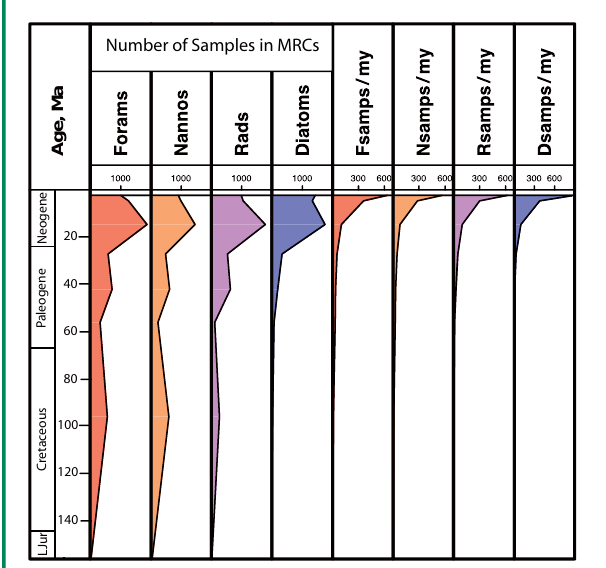
Figure 2. MRC samples vs. age, by geologic time interval. Absolute numbers in four columns on left are normalized to time interval for four columns on the right based on ages in MRC database (variable sized bins refl ecting sample size—Cenozoic by epoch, Mesozoic